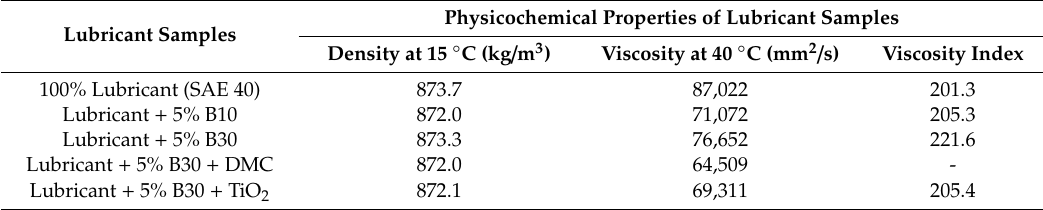
Table 3. Physicochemical properties of tested lubricant fuel samples.